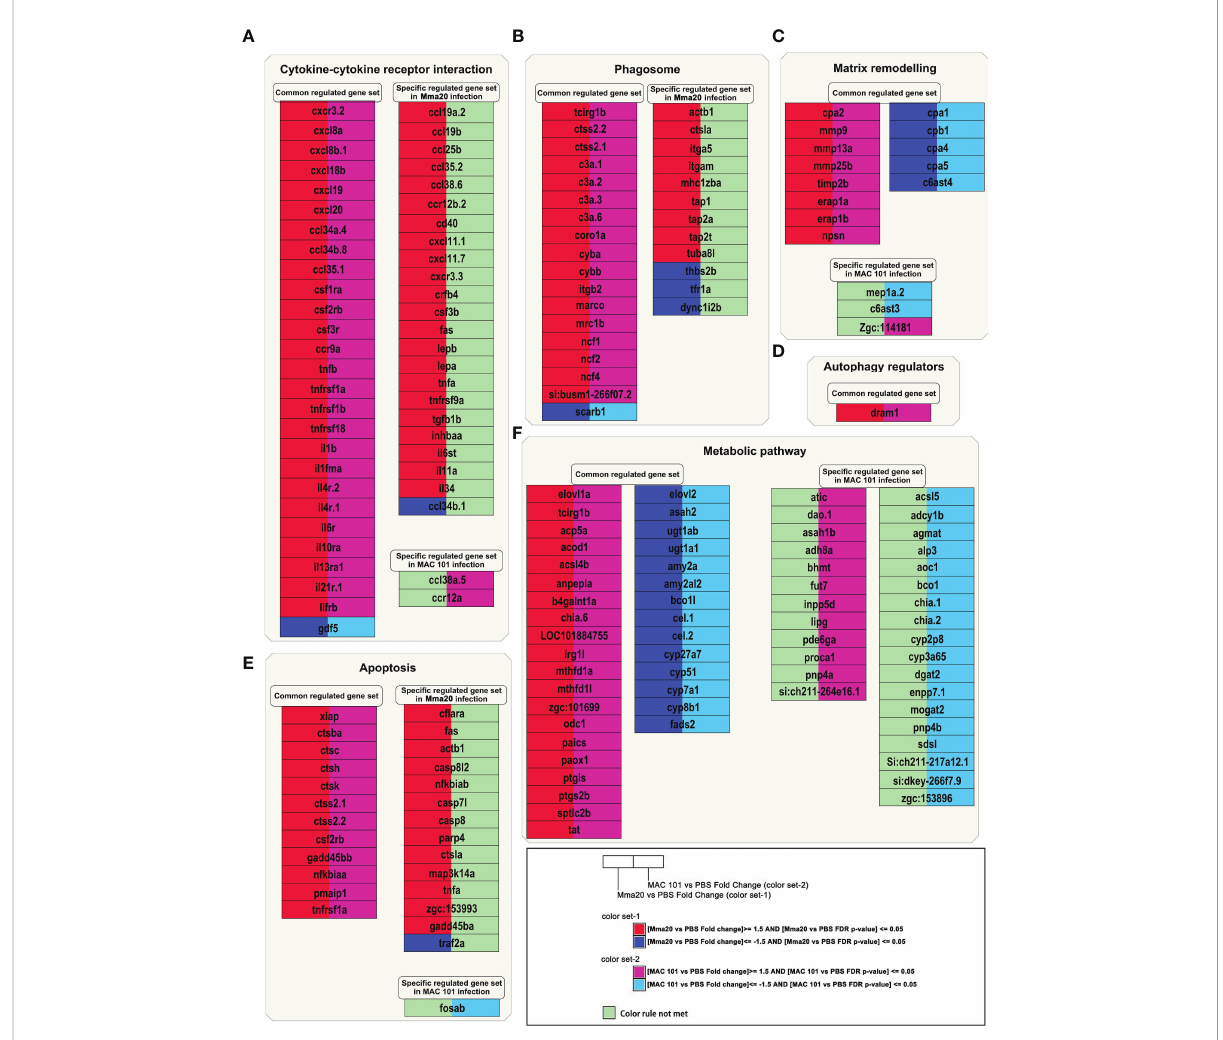
FIGURE 6 Common and speci fi c gene expression pro fi les of larvae infected with M. marinum Mma20 or M. avium MAC 101. DEGs from the Mma20- infected and the MAC 101- infected groups compared to the control group are showing in (A) Cytokine and cytokine receptor interaction; (B) Phagosome; (C) Matrix remodeling; (D) Autophagy regulator; (E) Apoptosis; (F) Metabolic pathway; In the visualization, the gene expression in the comparison of the Mma20- infected and the MAC 101- infected compared to the control group are depicted by color (red, upregulated genes in Mma20- infected group; blue, downregulated genes in Mma20- infected group; Magenta, upregulated genes in MAC 101- infected group; Cyan, downregulated genes in MAC 101- infected group. FDR p-value <